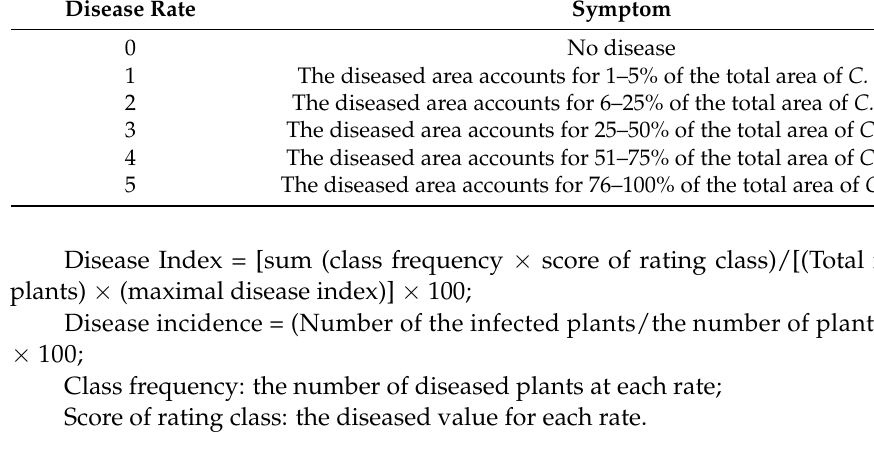
Table 1. Disease classification standard. Disease